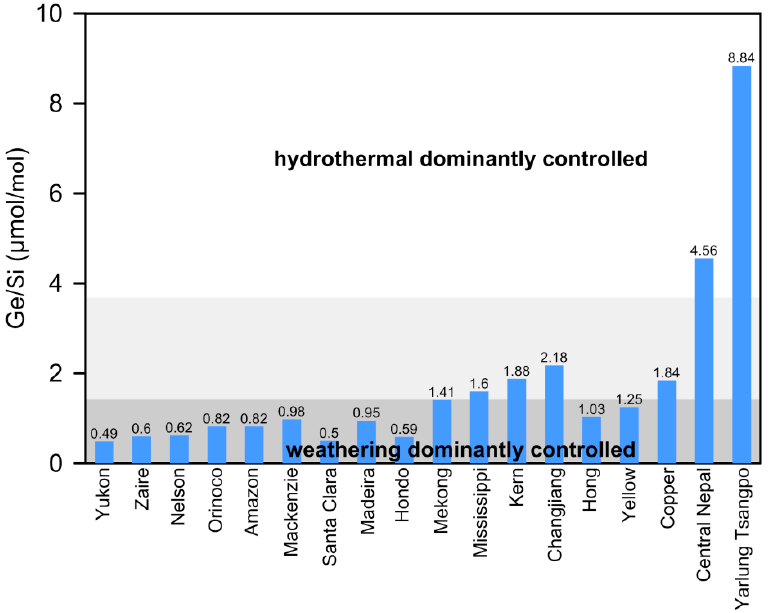
Figure 9. Ge/Si ratio histogram of the Yarlung Tsangpo River and other typical basins. Data of Zaire River, Yukong River, Orinoco River, and Nelson River are from [16] . Data of Amazon River, Mackenzie River, Mekong River, Mississippi River, Changjiang River, Kern River, Santa Clara River, Madeira River, and Hondo River are from [23] . Data of Hong River is from [7] . Data on the Yellow River is from [9] . Data of Copper River is from [18] . Data of Central Nepal Rivers is from [30] .